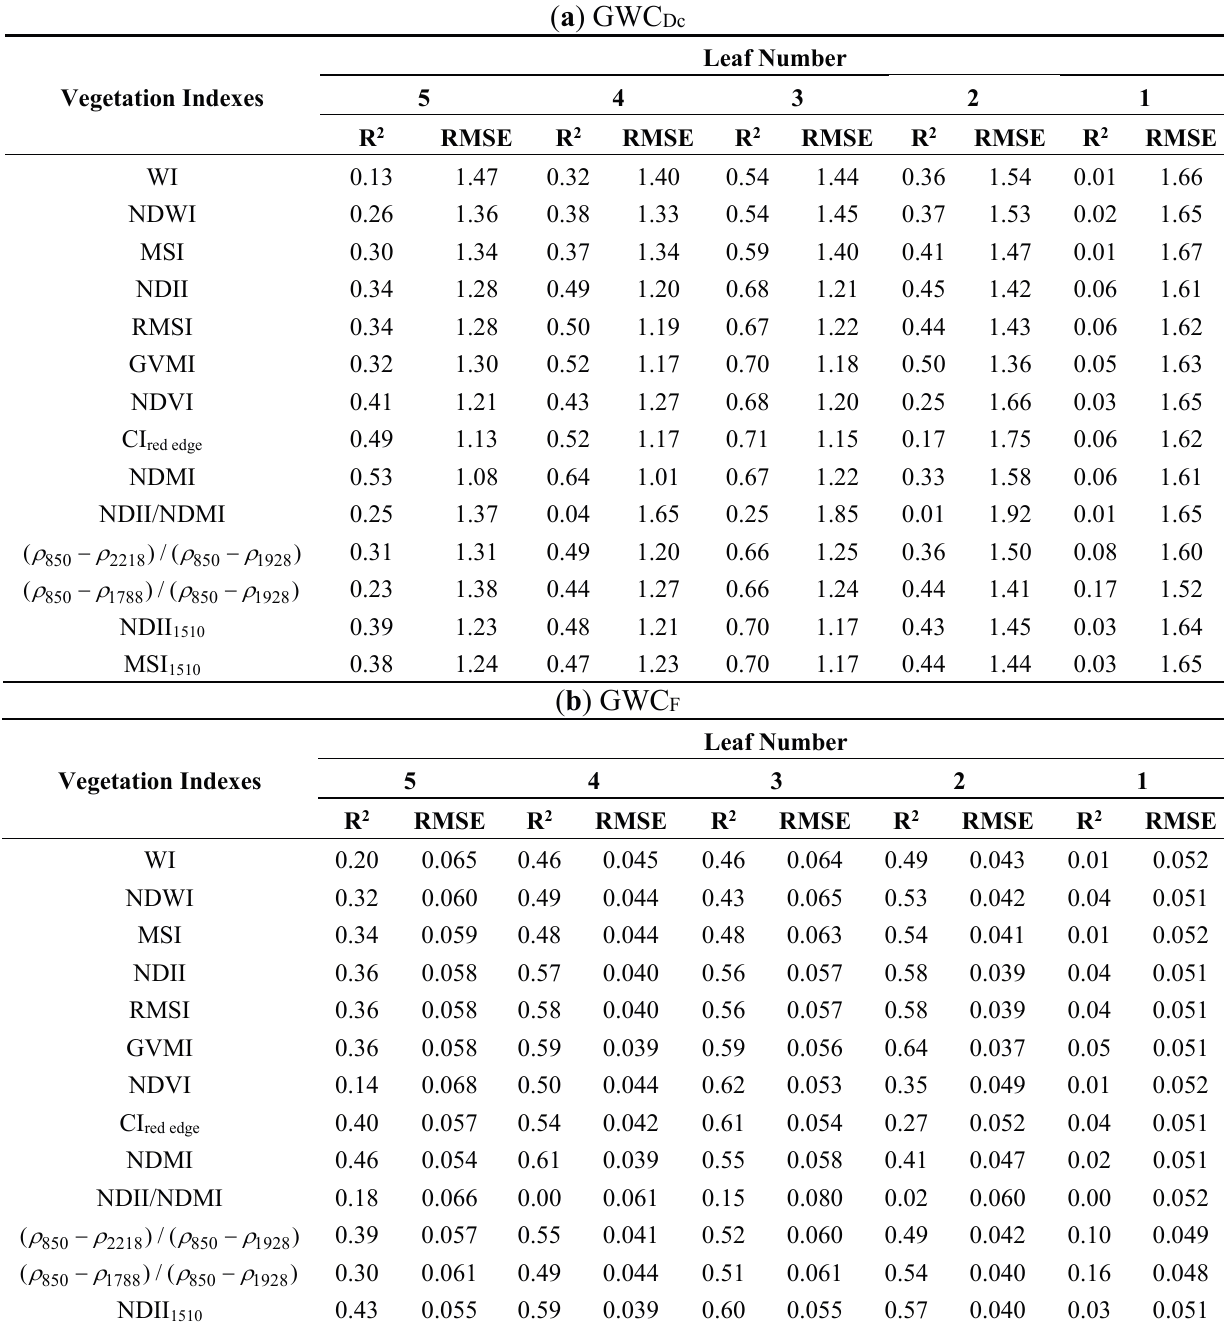
Table 6. Statistics of relationships between VIs and GWC D ( a ), GWC F ( b ), RWC ( c ), and EWT ( d ) for each leaf layer from the top (No.5 refers to the top leaf) to the bottom ((No.1 refers to the bottom leaf) of the winter wheat. Given the number of samples (28 samples), the significant relationships ( p < 0.001) were indicated by R 2 values greater than